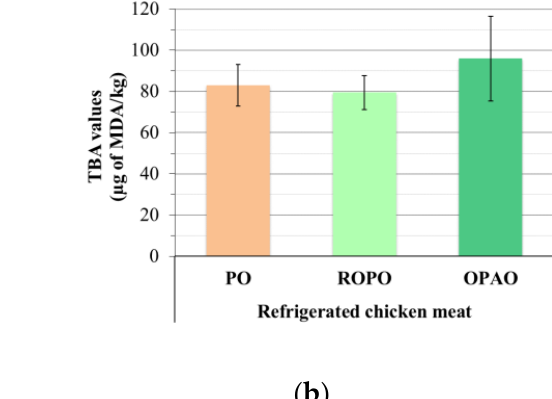
Table 6. Volatile compounds (µg/kg) of fresh and refrigerated dark chicken meat with skin. Hexanal 1